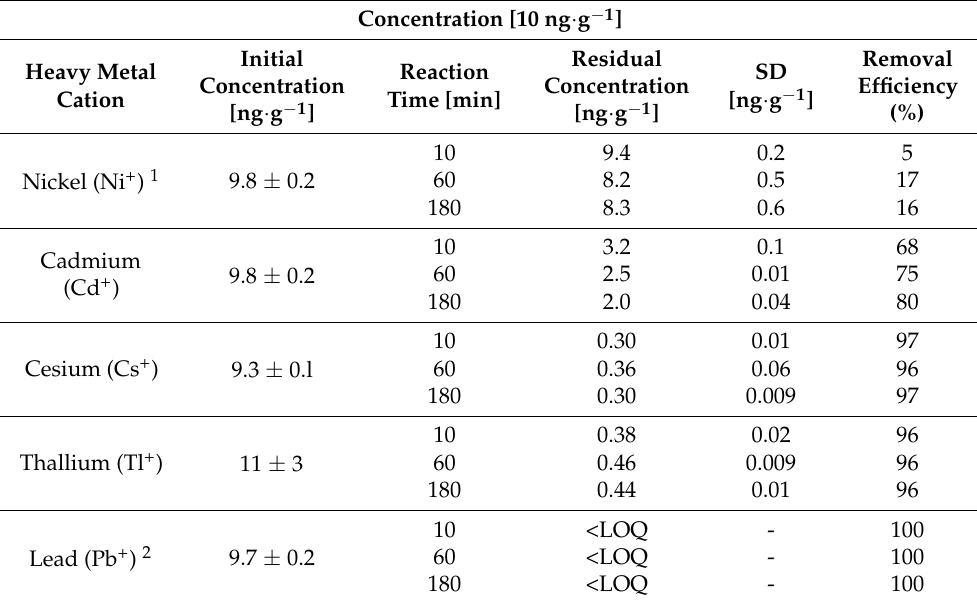
Table 3. Adsorption of studied heavy metal cations from single-element solutions with concentrations of 10 ng · g − 1 onto